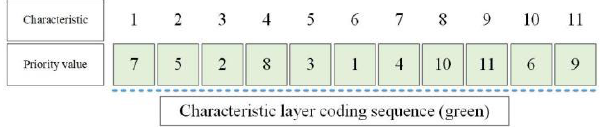
Figure 2. Feature layer encoding sequence.